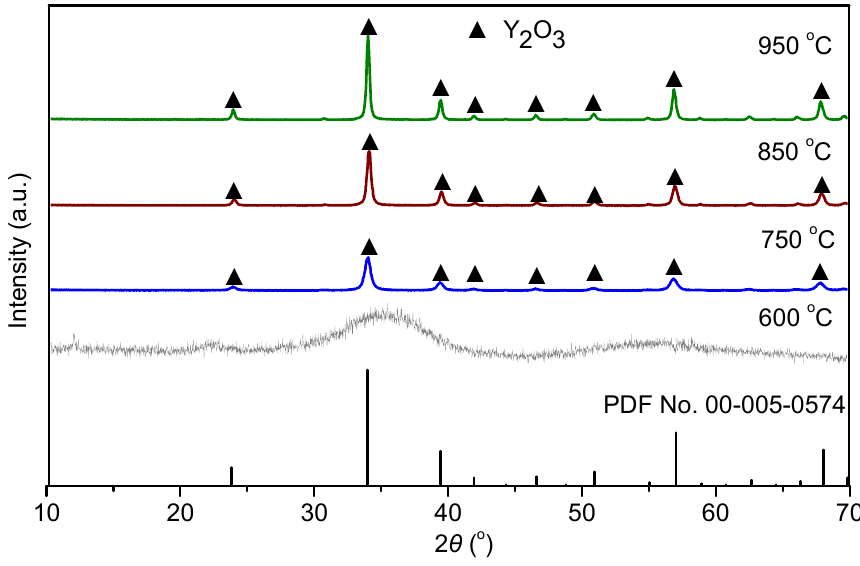
Figure 6. XRD pa tt erns of y tt ria precursor after calcining at di ff erent temperatures. Figure 6. XRD patterns of yttria precursor after calcining at different